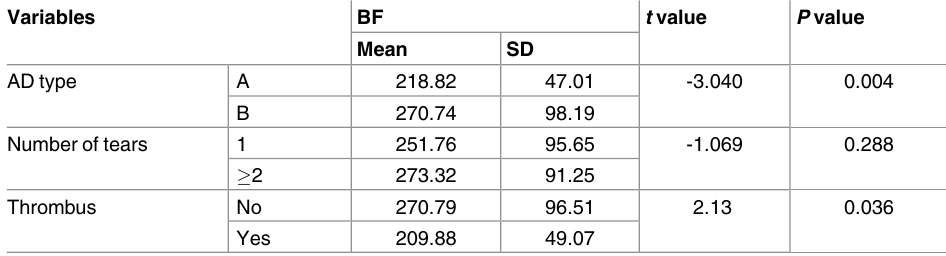
Table 2. Independent-Samples T test.